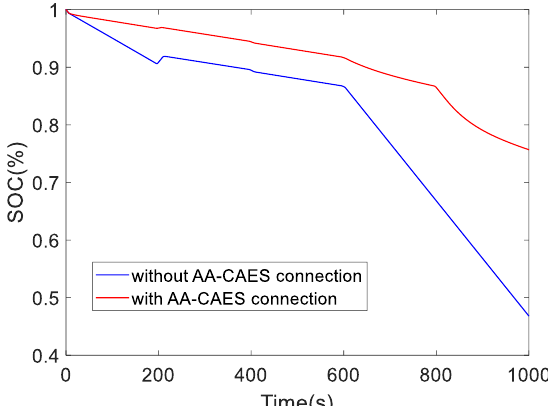
Figure 42. Change in SOC value of storage battery when light intensity fluctuates.